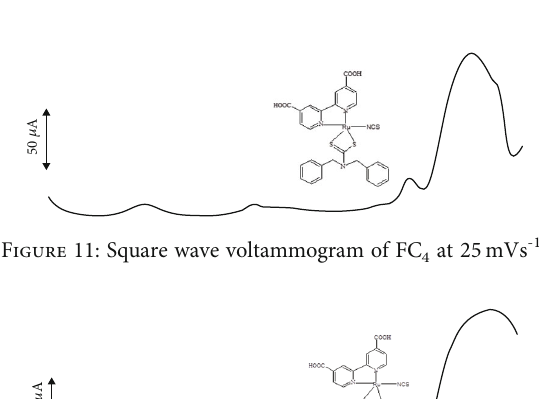
Figure 10: Square wave voltammogram of FC